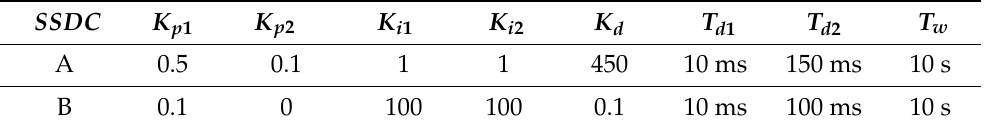
Table 5. SVC control gains and SSDC considered in Section 3.3.1.